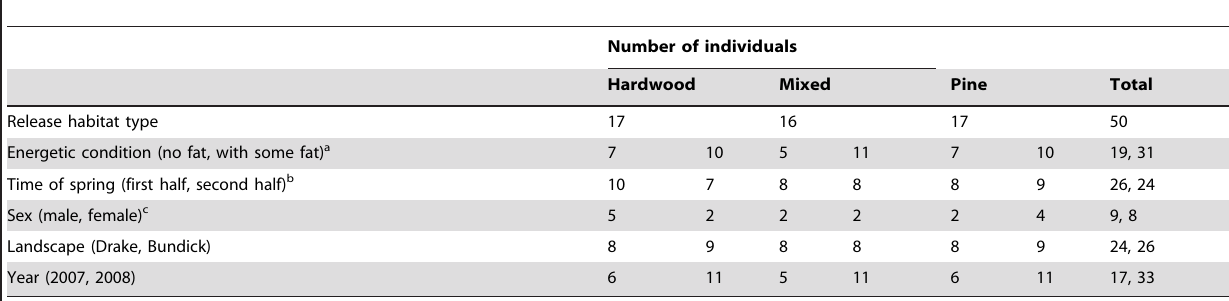
Table 1. Summary of migratory red-eyed vireos released and tracked in two replicates of three forested habitat types.